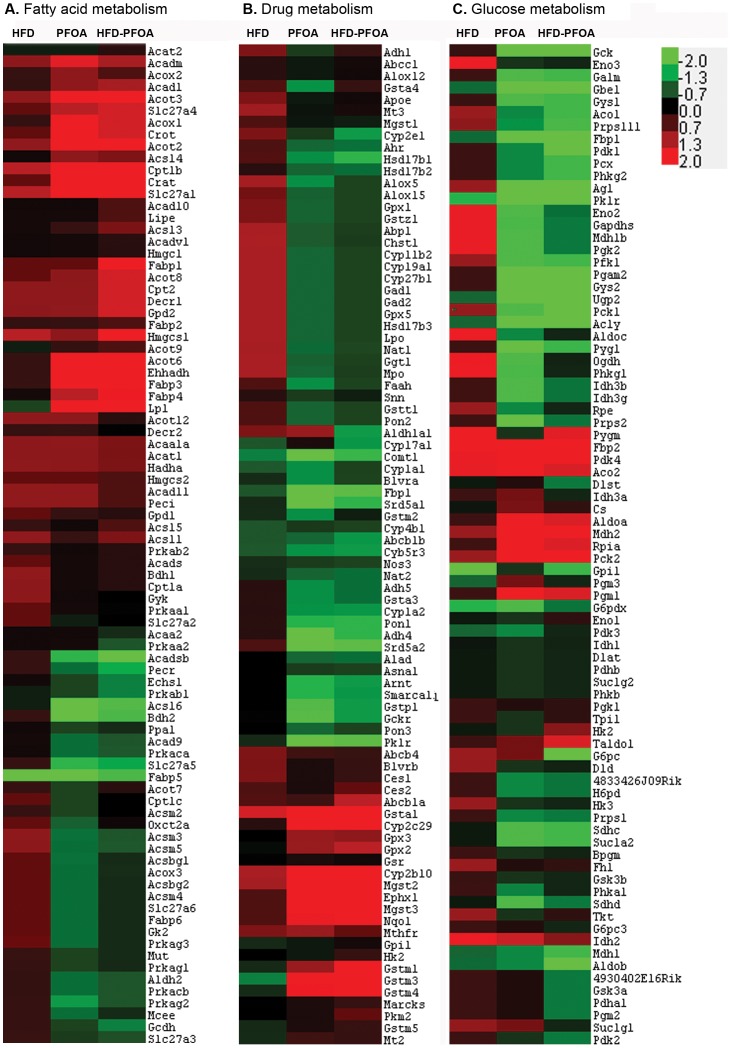
Gene expression profiles in the liver of mice fed HFD or/and PFOA.Adult mice were pair-fed a high-fat diet (HFD) or low fat control diet (CTRL) with or without perfluorooctanoic acid (PFOA) administration at 5 mg/kg/day for 3 weeks. The mRNA levels were analyzed by RT2 Profiler™ PCR Array (n = 3). A. Genes related to fatty acid metabolism. B. Genes related to drug metabolism. C. Genes related to glucose metabolism. Red and green corresponds to average up- and down-regulation, respectively.